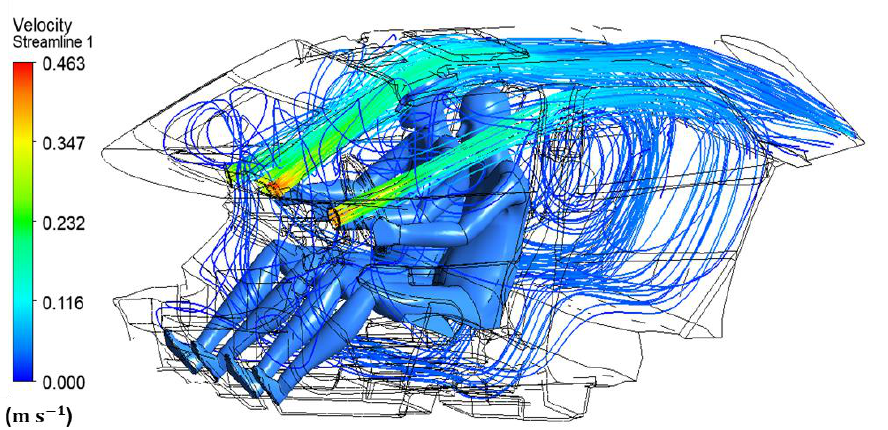
Figure 6. Velocity streamlines inside the vehicle cabin.